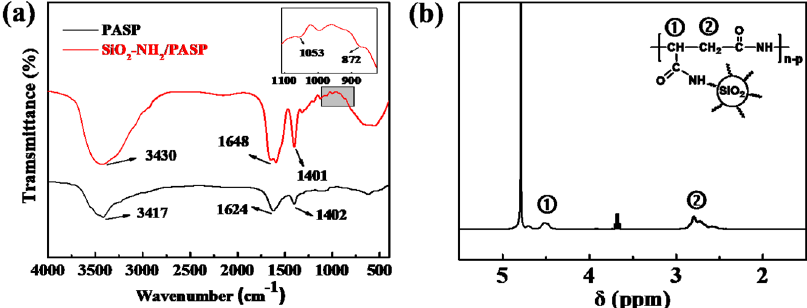
Fig. 2 Structural characterization of polymer. a FTIR spectra of PASP and SiO 2 – NH 2 /PASP, b 1 H NMR spectra of SiO 2 – NH 2